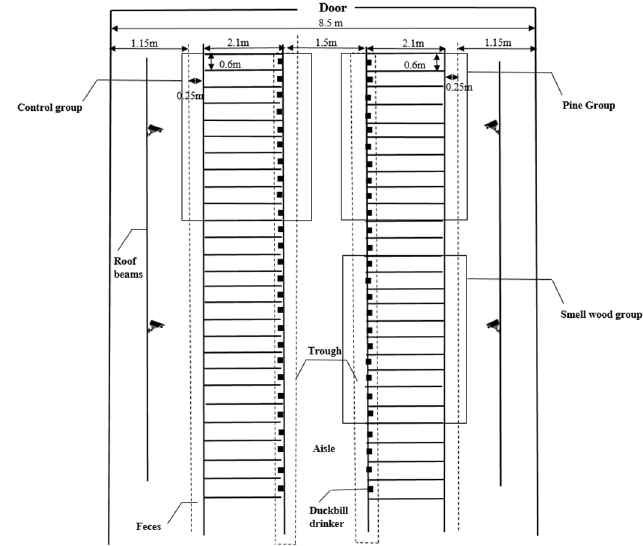
Table 1. Nutritional composition of pregnant sow feed.